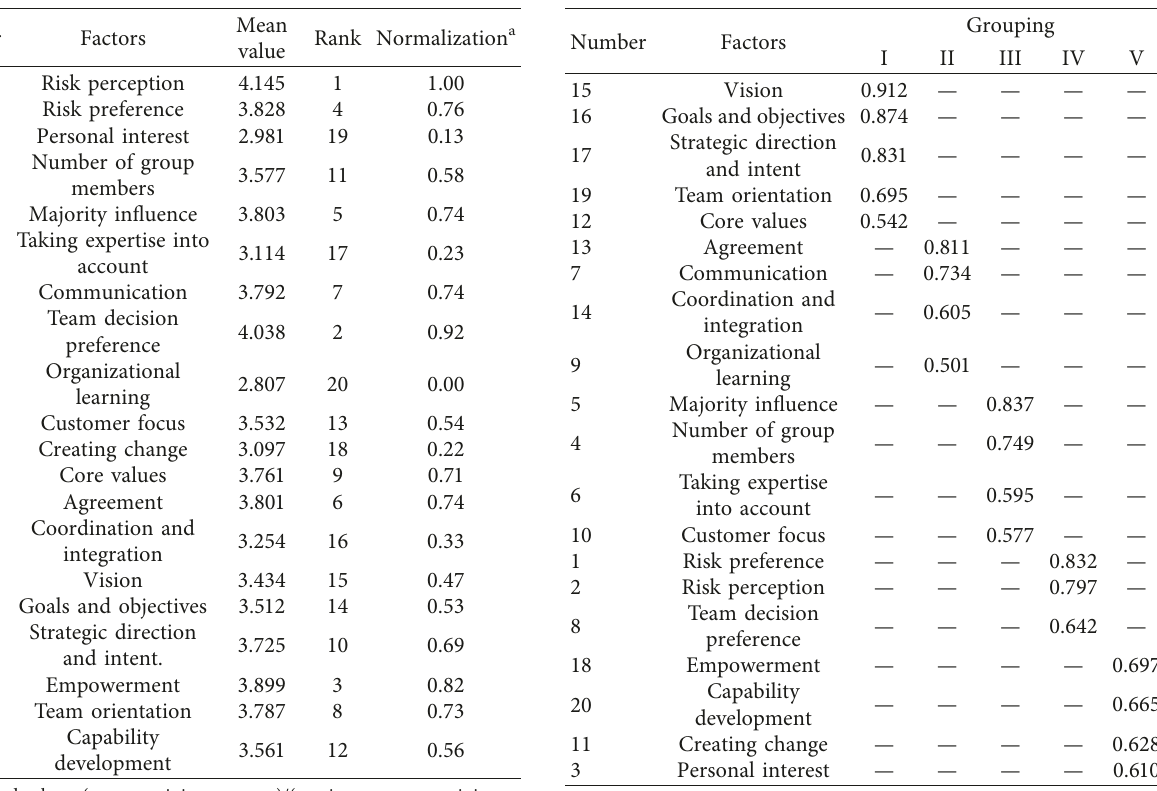
Table 3: Ranking of the factors.